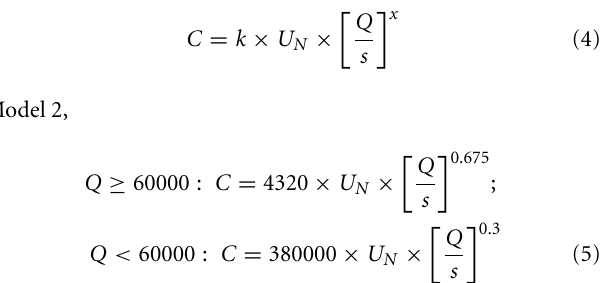
Model 4: total cost of production method (production rate, raw material, and product